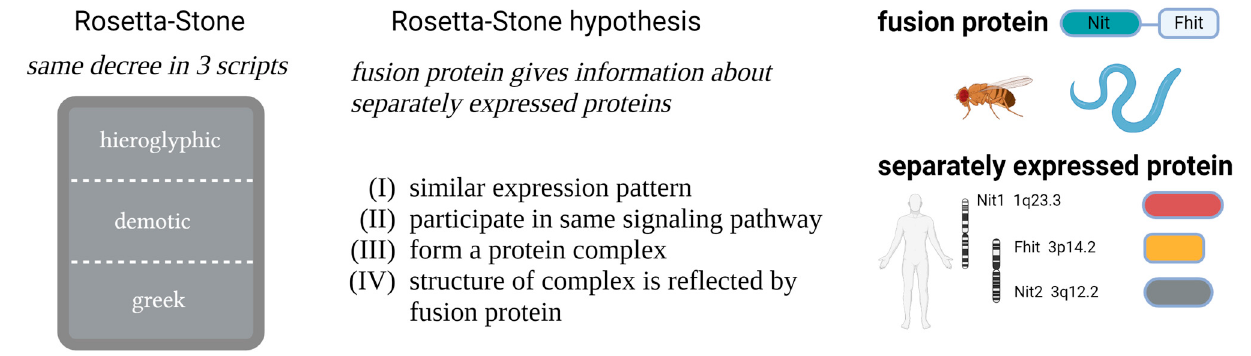
Figure 1. Nit1/Fhit and the Rosetta Stone hypothesis: history, postulates, and Nit/Fhit proteins (created with BioRender.com; accessed on 30th November 2022).